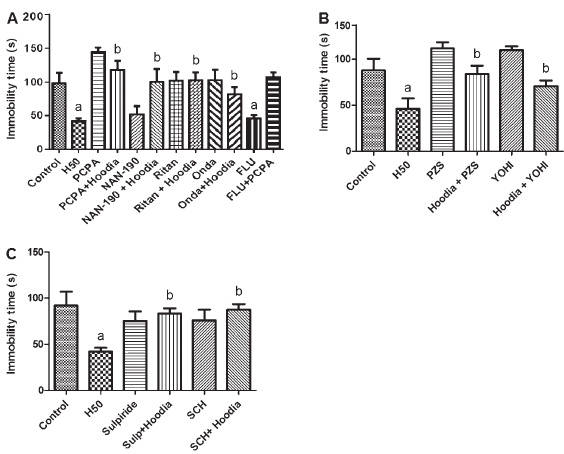
Figure 3. Effects of Hoodia gordonii in the forced swimming test on serotonergic, noradrenergic and dopaminergic systems. A , Pretreatment of animals with p -chlorophenylalanine methyl ester (PCPA, 100 mg/kg, ip ), ritanserin (Ritan, 1 mg/kg, ip ), ondanse- tron (Onda, 1 mg/kg, ip ) or vehicle on the effects of H. gordonii (H50, 50 mg/kg, po ). Fluoxetine (Flu, 35 mg/kg, ip ) was used as positive control. B , Pretreatment of animals with prazosin (PZS, 1 mg/kg, ip ) or yohimbine (YOHI, 1 mg/kg, ip ), and C , with sulpiride (50 mg/kg) and SCH23390 (0.05 mg/kg) or vehicle on the effects of H. gordonii (50 mg/kg, po ). Results are reported as means±SE. a P , 0.05, compared to control; b P , 0.05 compared to H. gordonii (ANOVA and Student-Newman-Keuls post hoc test).